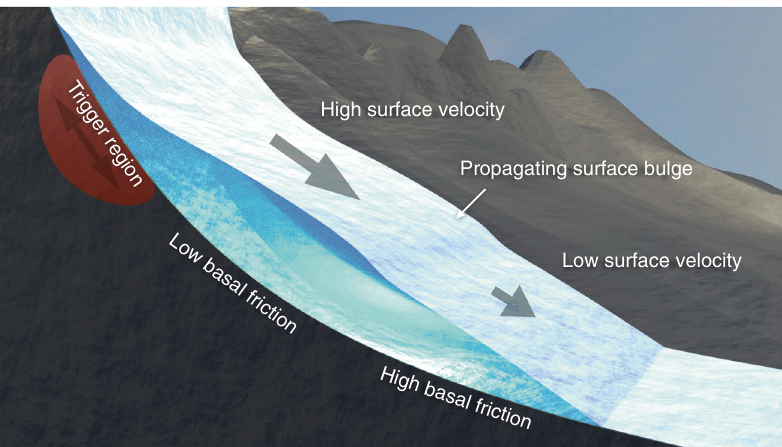
Fig. 1 Sketch of the model system based on the Variegated Glacier. A glacier surge often propagates down-glacier from a triggering region accompanied by a traveling surface bulge. To model surge propagation, we introduce a rate-and-state type sliding law that exhibits a transition from velocity-strengthening to velocity-weakening friction where the frictional strength evolves over a characteristic length scale d c . Low basal friction behind a surge front occurs spontaneously in the model due to this transition, and the propagation of the surge is governed by d c